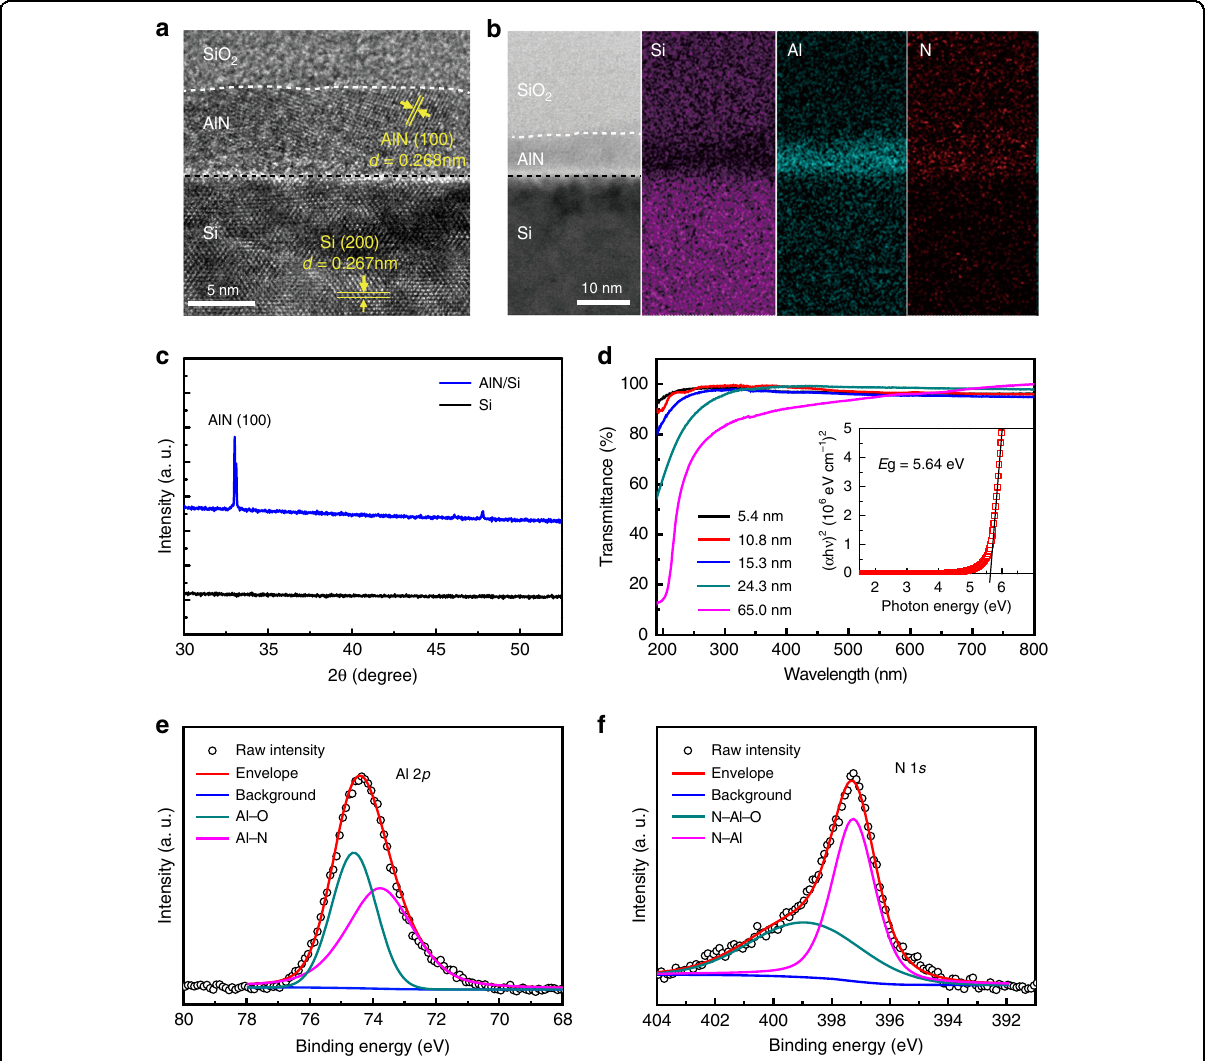
Fig. 2 Morphology, crystallinity, and optical characterization of the AlN fi lm. a Cross-sectional HR-TEM image of the ALD deposited AlN fi lms on Si substrate and b the corresponding EDX elemental mappings. c XRD patterns of the bare Si substrate and 65 nm AlN fi lm grown on Si. d Optical transmission spectra of AlN fi lms grown on sapphire substrates with different thicknesses. The Tauc plot for the estimation of the bandgap of AlN was shown in inset. e , f Shows the XPS spectra for Al 2 p and N 1 s of the AlN fi lm,